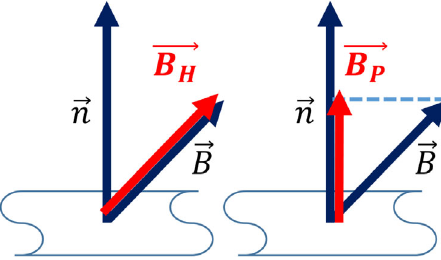
⃗ B two simulations. is the ambient field, ⃗ n is the normal vector on the cavity surface. The red arrows indicate the assumed trapped ⃗ B field for each model: H for homogeneous trapping same as the ⃗ B externally applied magnetic field, and P for trapping of the field components perpendicular to the cavity